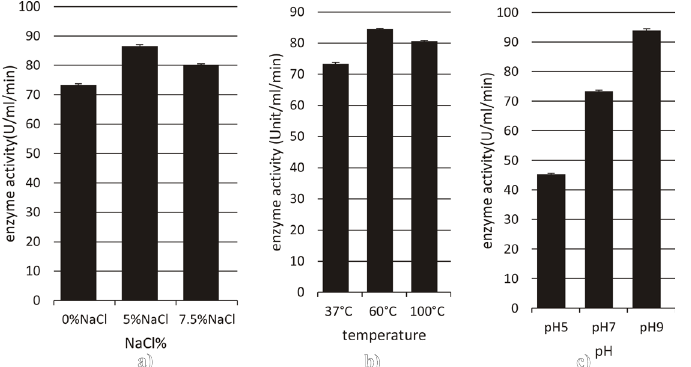
Fig. 9. Effect of different factors ( a : NaCl%, b : Temperature, c : pH) on activity of Caseinase enzyme from Streptomyces